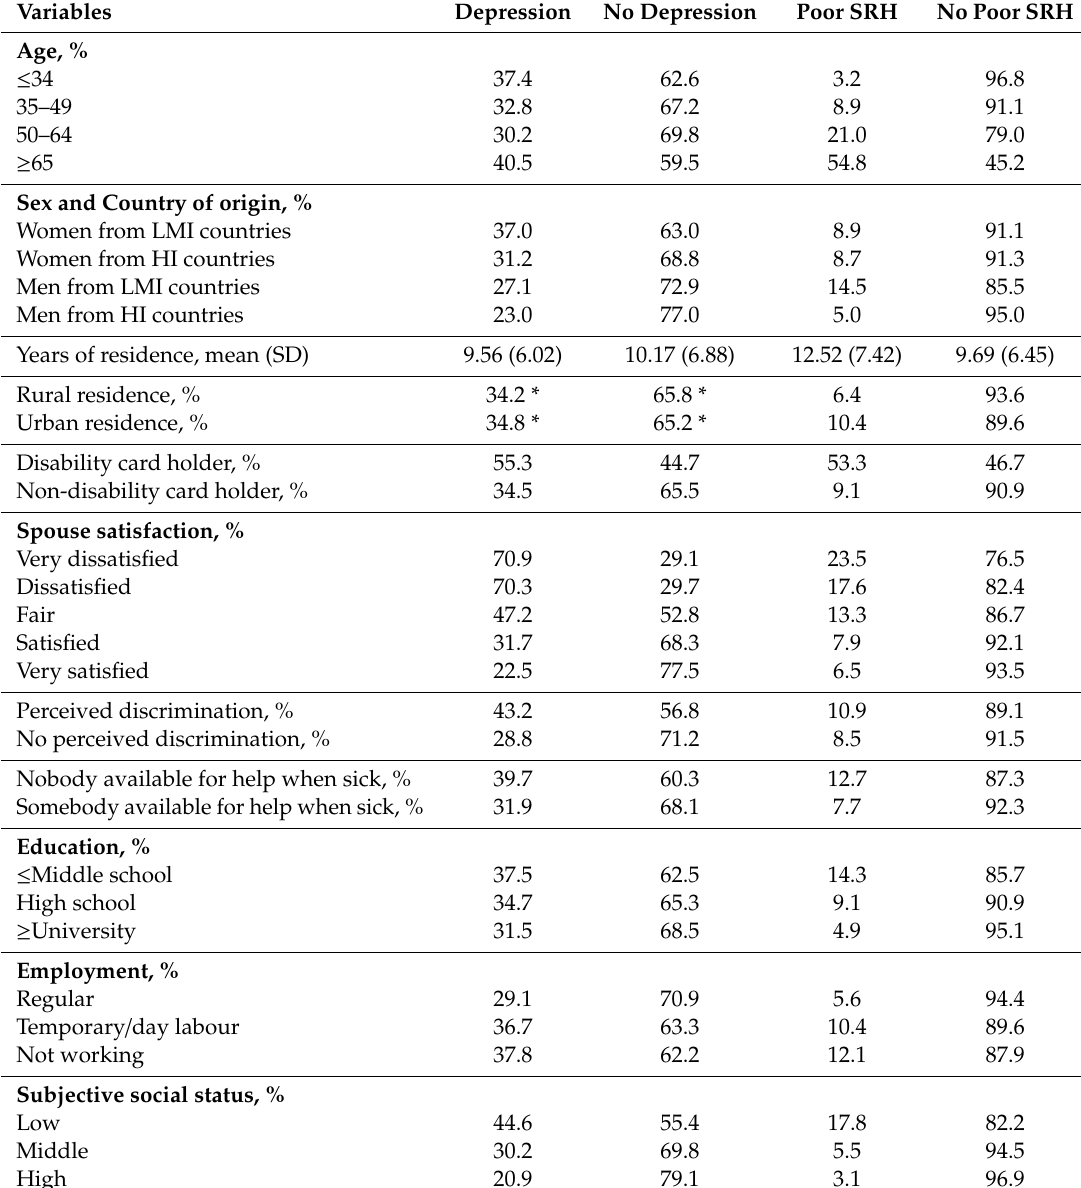
Table 1. Prevalence of self-reported depression and poor SRH by sociodemographic factors (weighted) ( n =